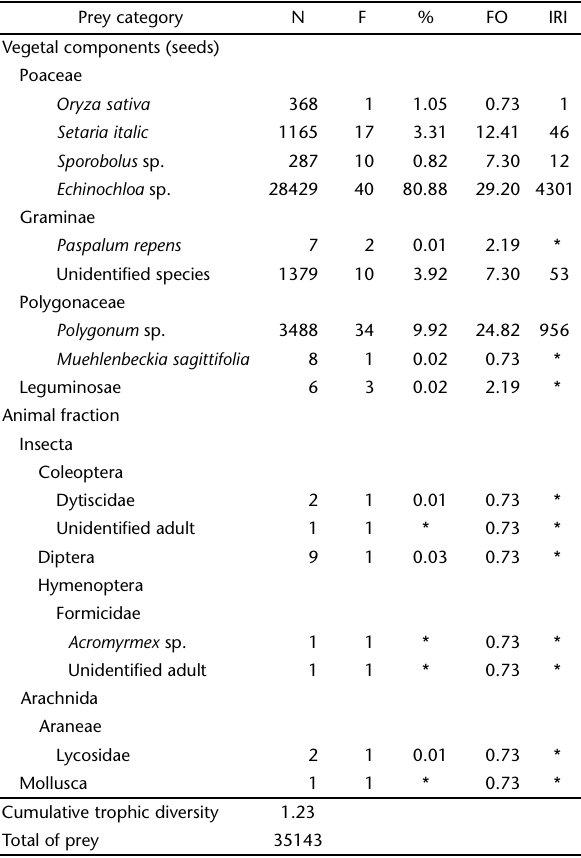
Table I. Trophic spectrum of Netta peposaca. Total number of organisms (N), Absolute frequency (F), Percentage of each prey category in the diet (%), Frequency of occurrence (FO), Index of relative importance (IRI), and without value